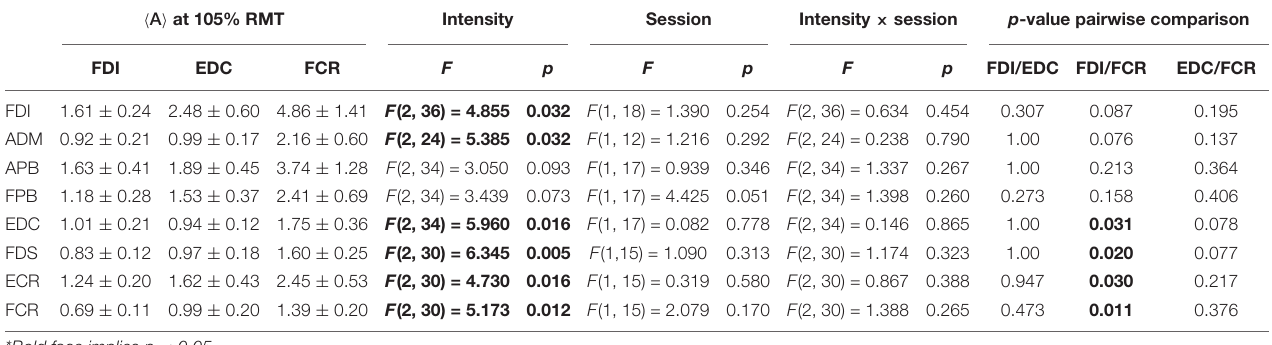
TABLE 2 | Outcomes of the two-way ANOVA for the area sizes A (in mm 2 · µ V · 10 5 ) with factors of intensity and session when considering the highest cortex mesh resolution and when removing the non-MEP points (M2)*. (cid:104) A (cid:105) at 105% RMT Intensity Session Intensity × session p -value pairwise comparison FDI EDC FCR FDI